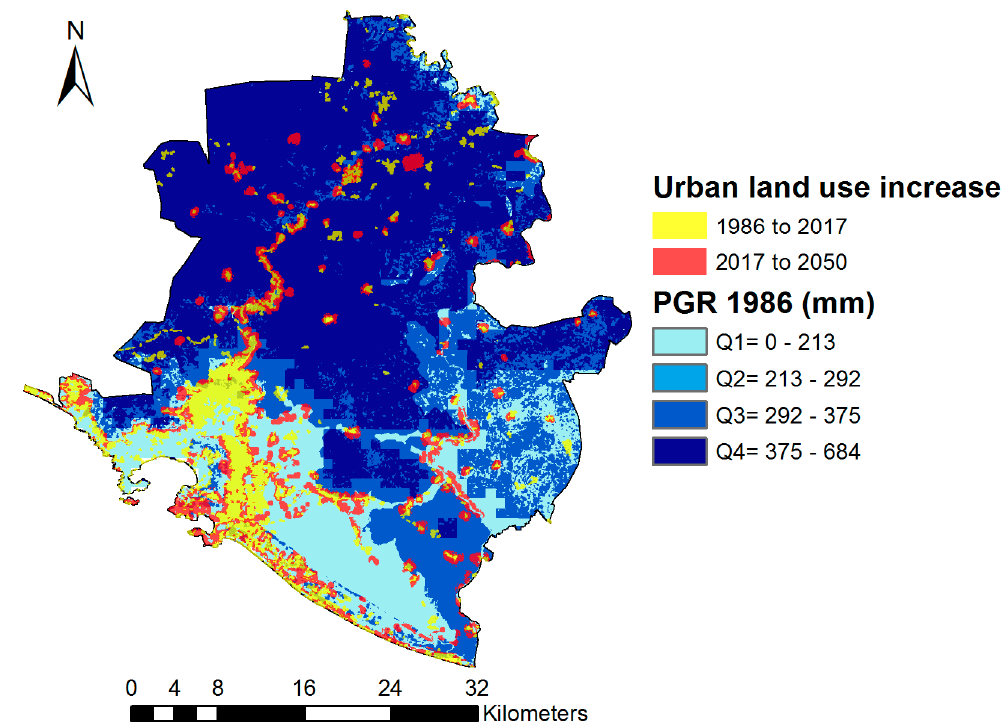
Figure 8. Urban LUCC for 2017 and 2050 is located in classified PGR classes.